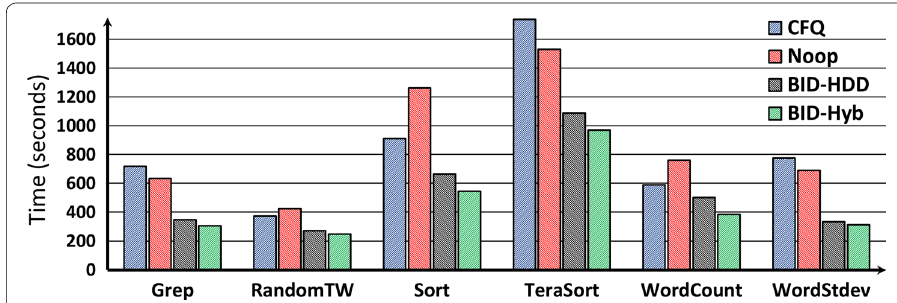
Fig. 12 Cumulative I/O completion